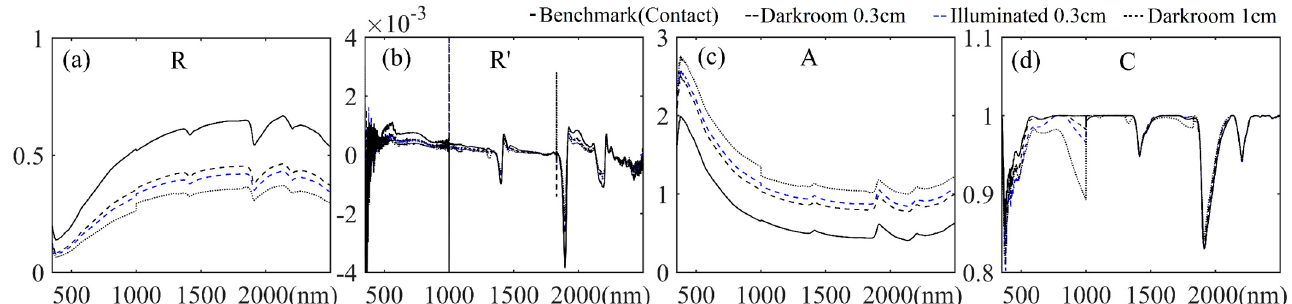
Figure 8. Average spectra of JL samples in light interference control experiments: ( a ) spectral reflectance (R); ( b ) the first derivative of the reflectance (R’); ( c ) the spectral absorbance (A); and ( d ) the spectra of continuum removal (C).